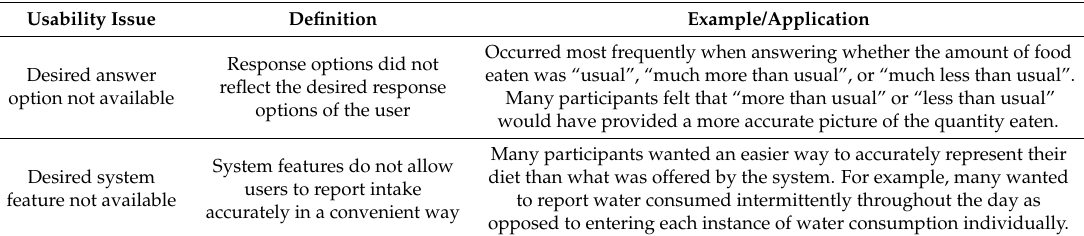
Table 6. Descriptions and examples of usability issues related to Satisfaction.